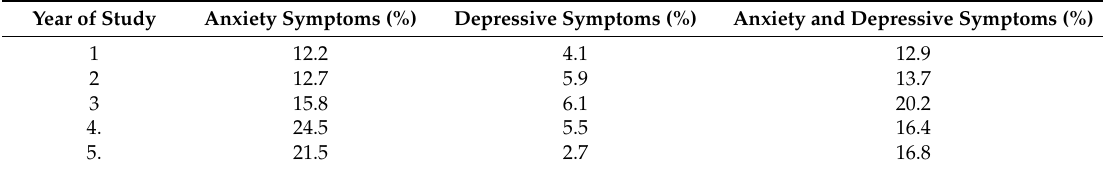
Table 2. Anxiety, depressive and mixed symptoms of medical students ( n = 622).